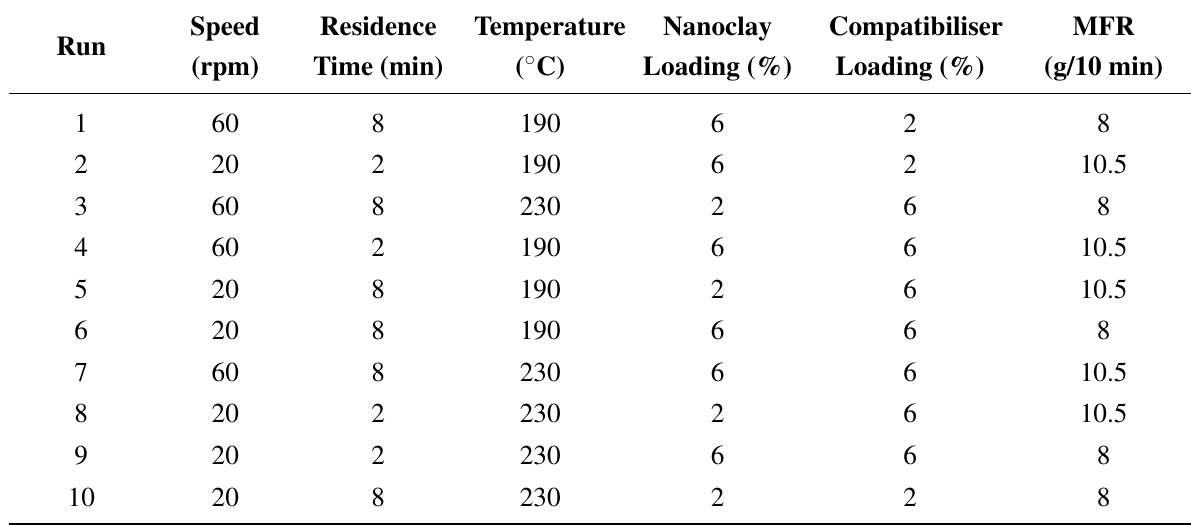
Table 1. The DoE run order of the experiments